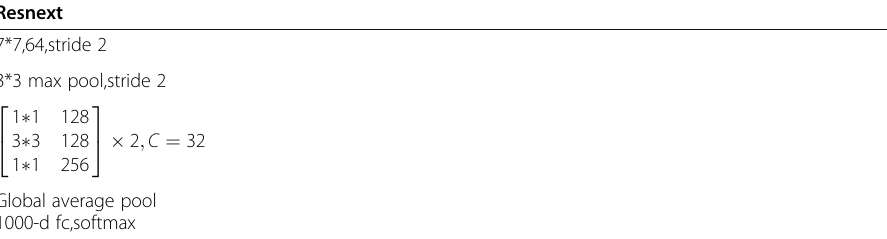
Table 3 Time-ResNeXt neural network structure Resnext 7*7,64,stride 2